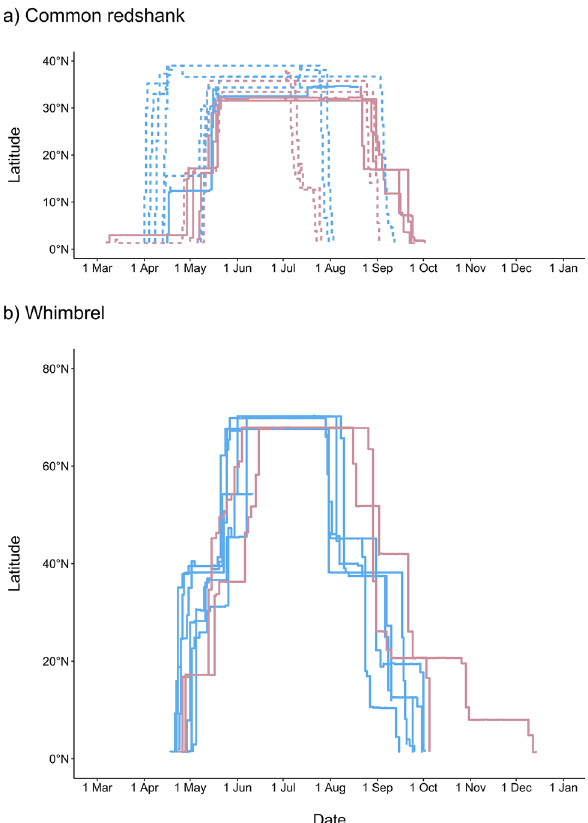
Figure 7. Timing and latitude of northward and southward migration of adult Common Redshanks and Whimbrels from Singapore. Migration chronology was estimated for birds tracked by geolocators (dashed lines; nine tracks of eight Redshanks in 2015 and 2016) or satellite transmitters (solid lines; four tracks of three Redshanks and eight tracks of five Whimbrels in 2018 and 2019). Red lines indicate birds that made a trans- Himalayan crossing; blue lines represent birds that migrated east of the Himalayan range (Redshanks) or along the East Asian-Australasian Flyway